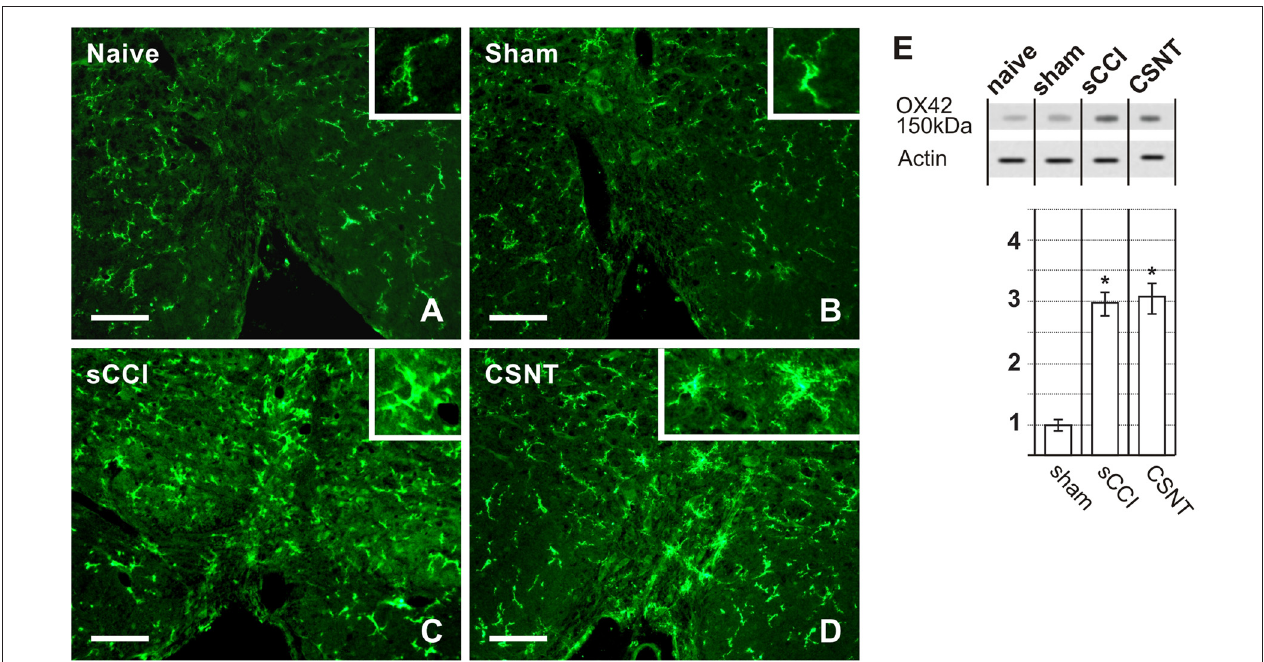
FIGURE 5 | Representative medullary sections showing RVM from naïve and sham-operated controls (A,B) and rats with sCCI or CSNT (C,D) . The pictures illustrate increased intensity and enlargement of OX42 immunostaining after sCCI and CSNT when compared to RVM from naïve or sham-operated rats. Insets show the typical morphological types of OX42+ microglial cells from the respective animal groups. Scale bars = 40 µ m. (E) Western blot analysis of OX42 (CD11b/c) protein. The top panel illustrates representative western blot in RVM of naïve and sham-operated rats and rats 3 weeks after sCCI or CSNT. Graph below the blot illustrates density data obtained from three blots after normalization to actin, expressed as fold-change relative to those of sham-operated rats (set as 1). ∗ Indicates a statistically significant difference ( p < 0.05) compared to the value from sham-operated